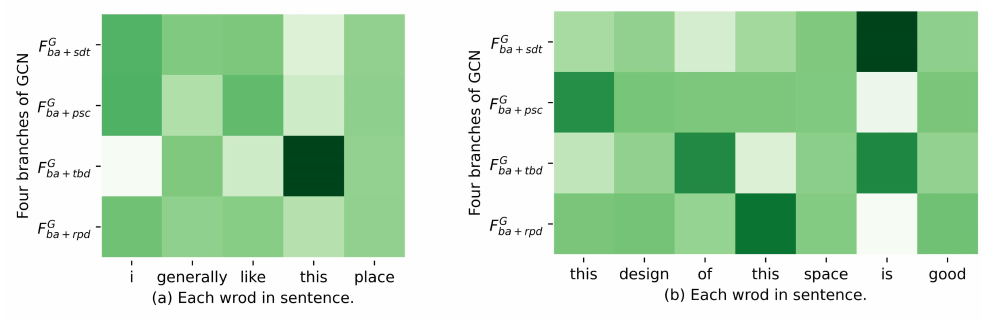
Figure 7. Attention distribution on each word in samples for case study.